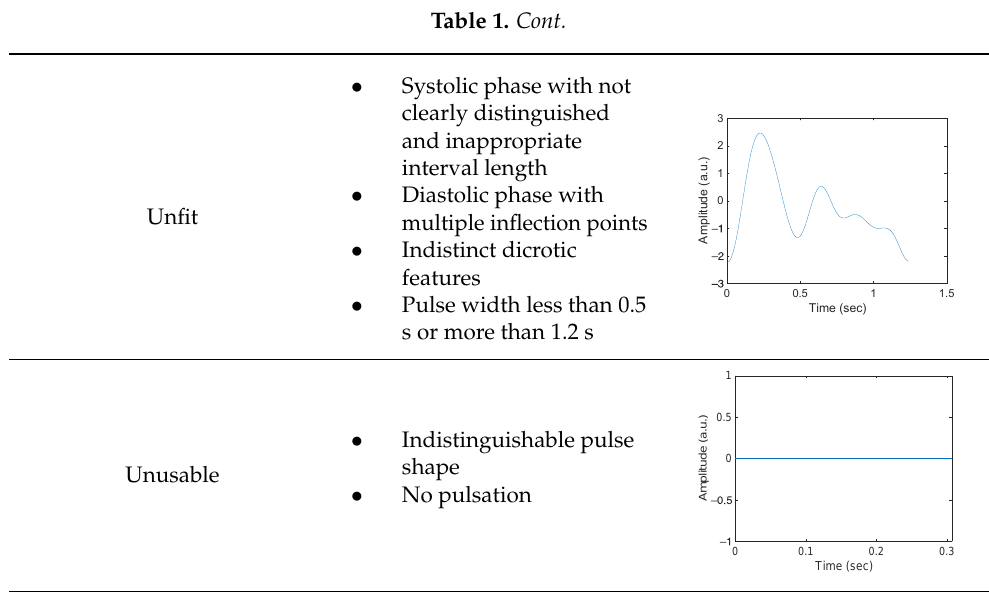
Table 2. Number of pulse segments corresponding to pulse quality labels.